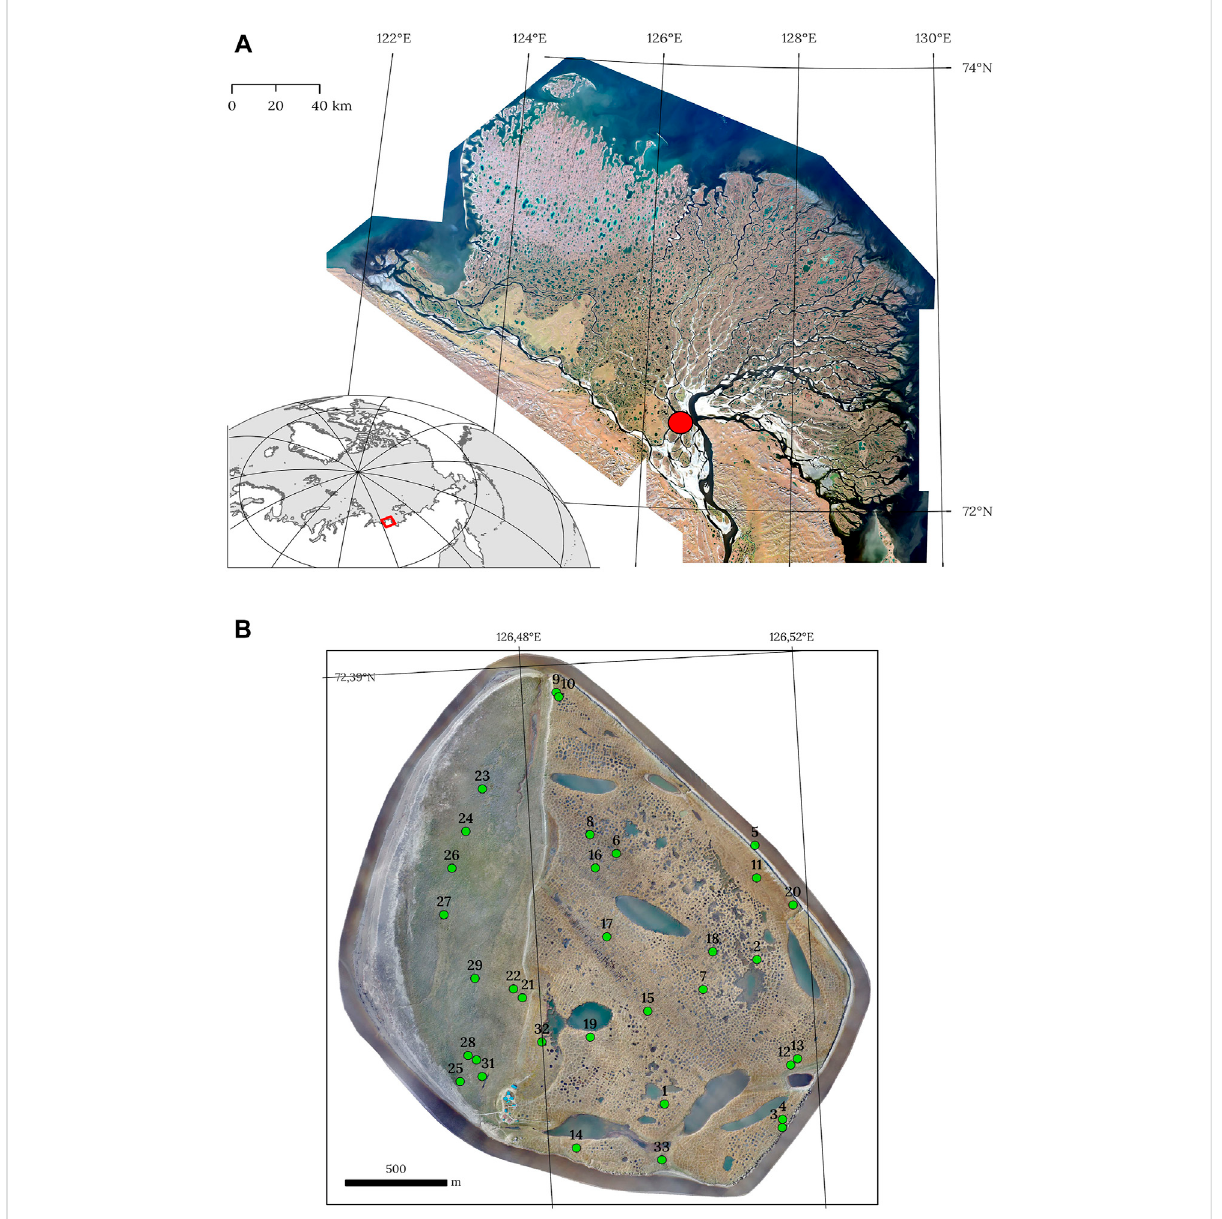
FIGURE 1 Studyarea. (A) LocationofSamoylovIsland(redsquare)inamosaicofsatelliteSentinel-2imagesoftheLenaDelta; (B) orthophotomapmosaic of Samoylov Island with observation